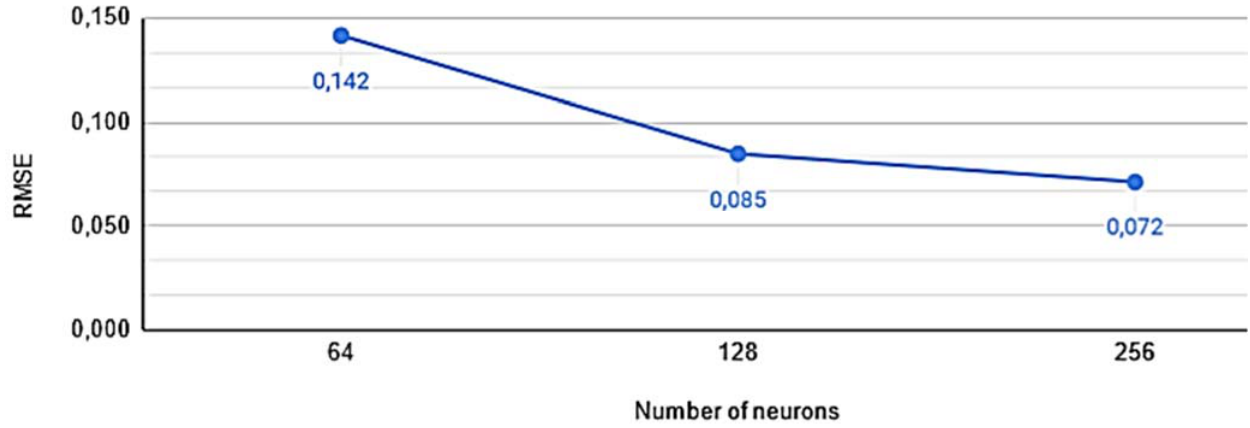
Figure 24. Average RMSE trend concerning the number of neurons in each layer for the validation set on 2 h prediction horizon.